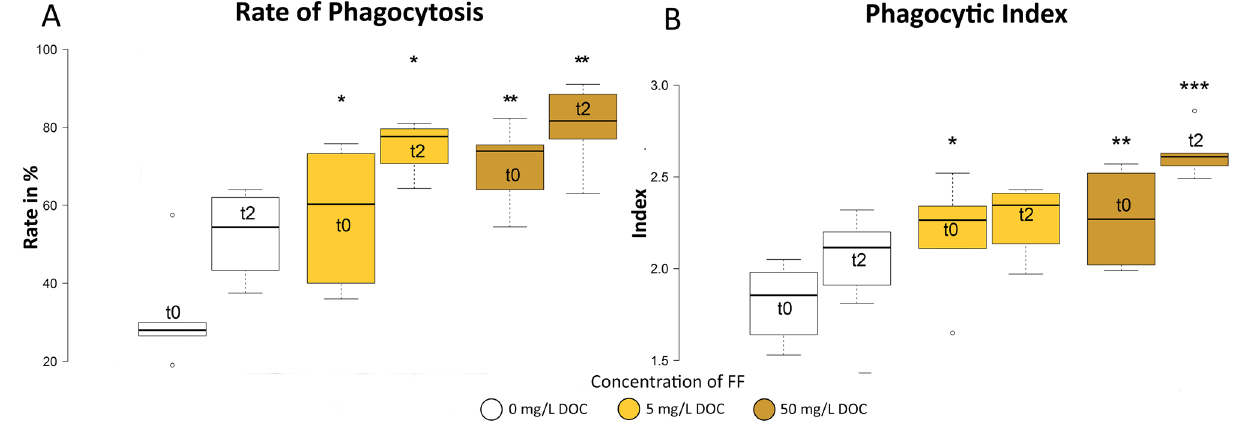
Figure 3. Rate of phagocytosis (A) and phagocytic index (B) of head kidney cells. t0: 28 days of exposure; t2: 2 days post stressor (t0). *p < 0.05; **p < 0.01; ***p < 0.001. n = 6.